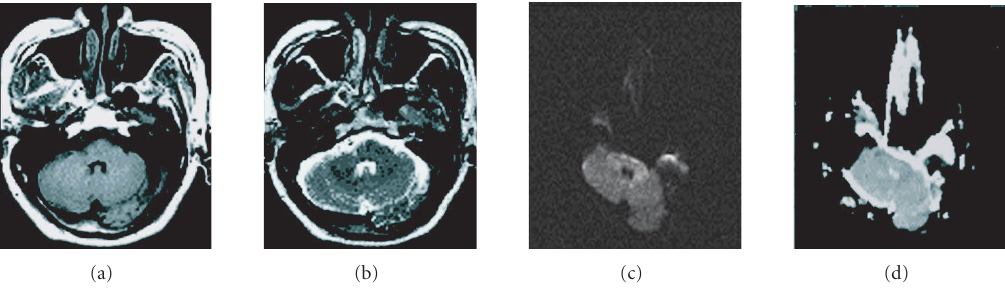
Figure 3: The same patient as in Figures 1 and 2. Hyperacute stage (7 days). T2-weighted image (a), T1-weighted image (b), DWI (c), and ADC map (d). No abnormity was found in each figure. The abnormity in DWI and ADC map have disappeared.